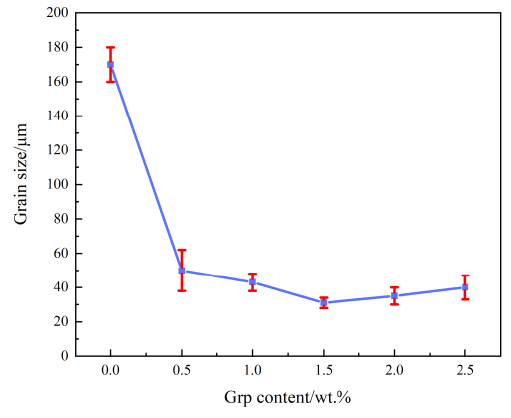
Figure 6. Variation of grain size of Graphite/AZ91D composites with different Grp content.